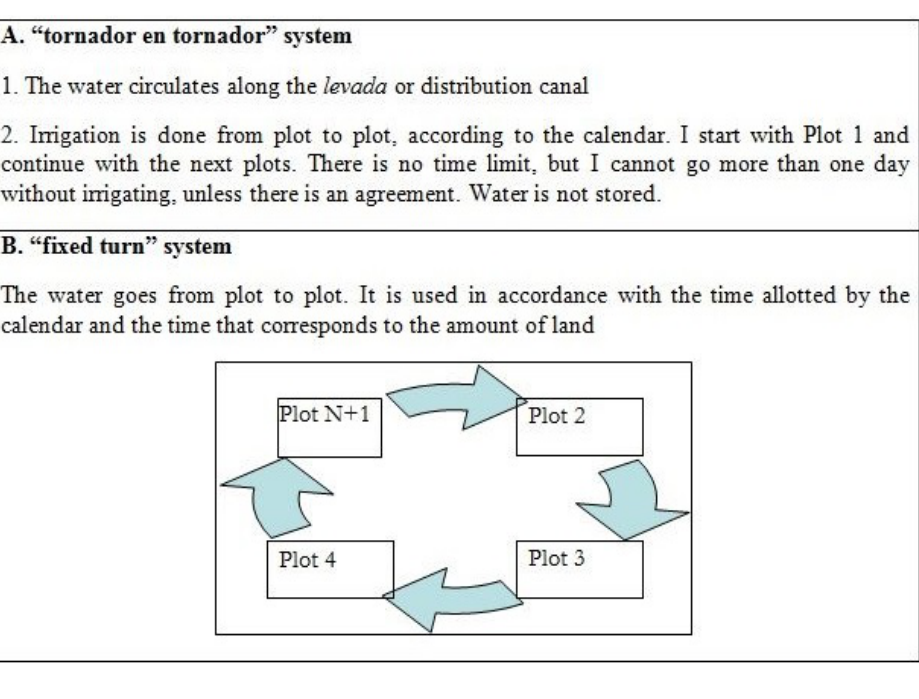
Scheme 2. Kind of calendar used for water distribution in Cape Verde.